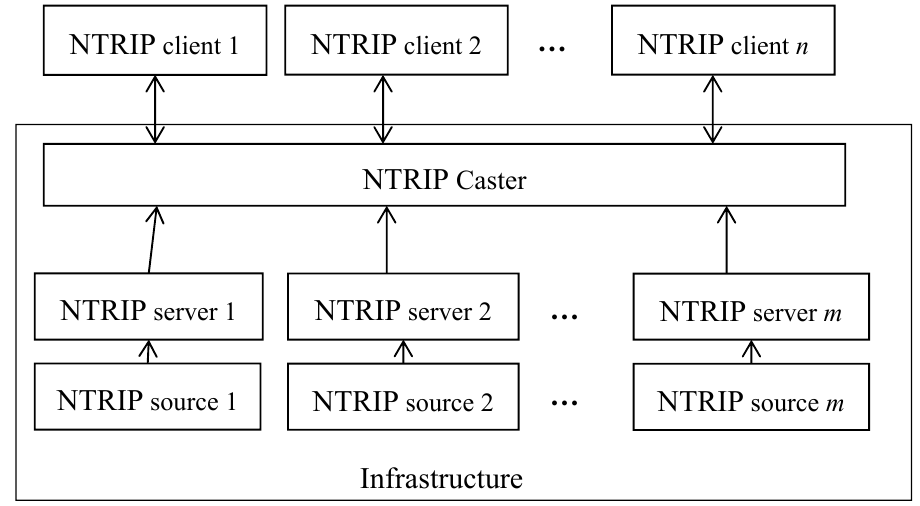
Figure 1. The logical structure of the network real-time kinematic (RTK) system. NTRIP: Networked Transport of RTCM via Internet Protocol.